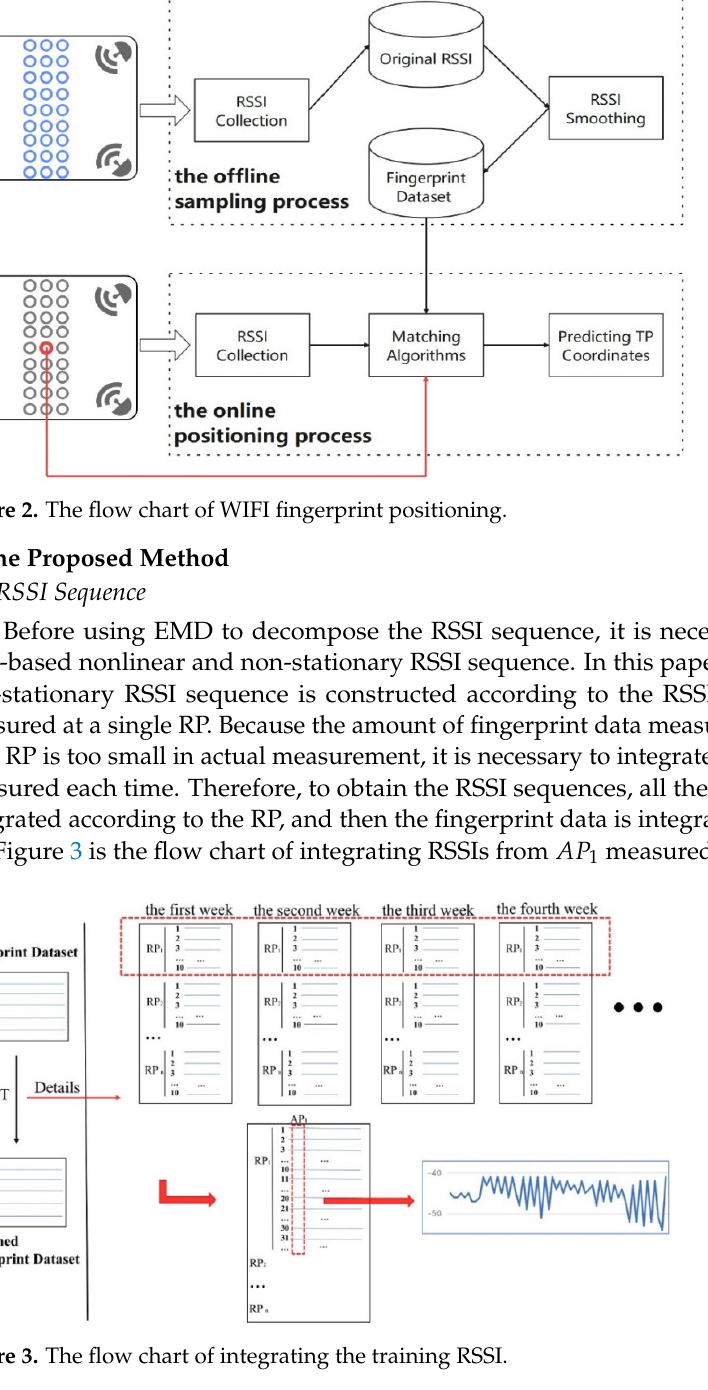
Figure 2. The flow chart of WIFI fingerprint positioning.